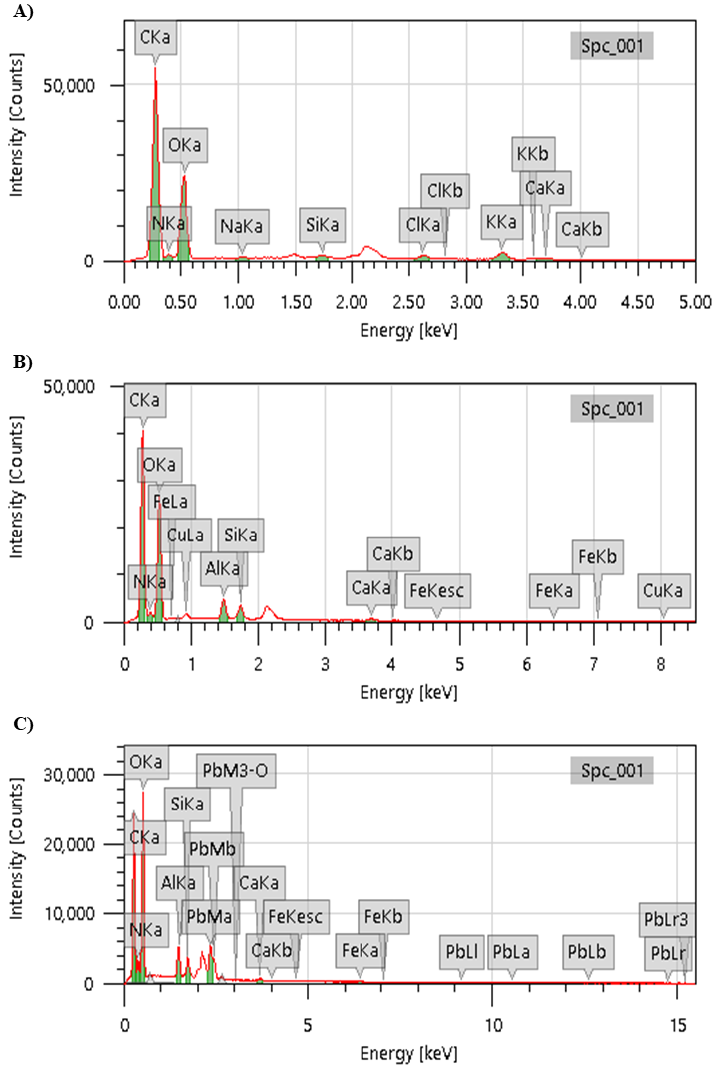
Figure 4. Energy dispersive spectroscopy (EDS) spectrums separated into peaks of the capital letters K, L or M indicate the shell containing the chemical element, whereas the greek letters (a = alfa, b = beta, r = ro, M = mi) indicate energy in Kev; in ground champignon ( A ), champignon after 20 min of contact with Cu ( B ), and after 120 min in contact with Pb ( C ).